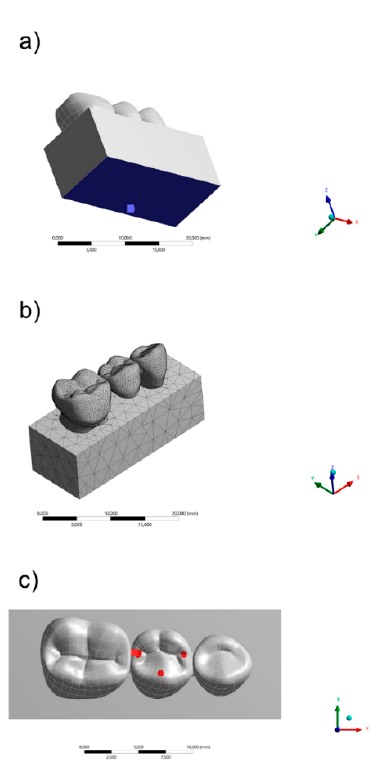
Figure 2. Finite element model showing ( a ) fixed support, ( b ) meshing division and ( c ) occlusal loading.